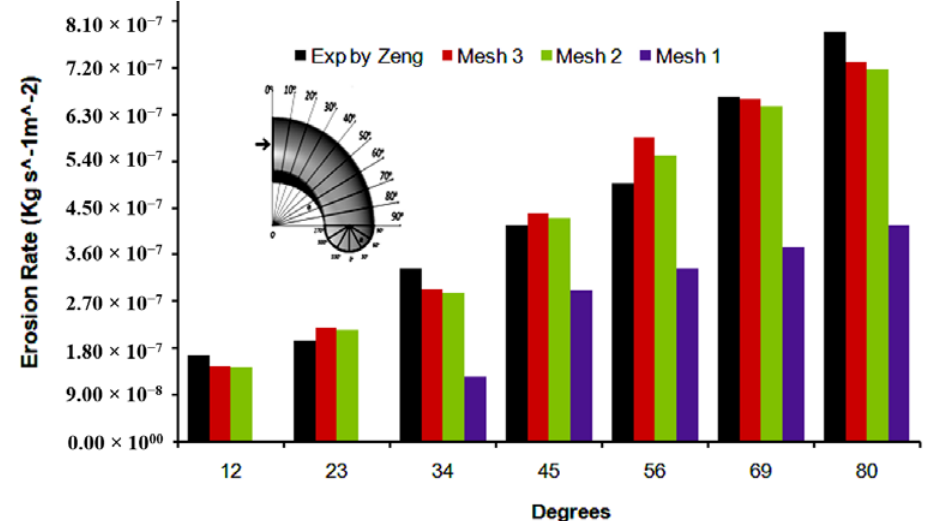
Figure 9. Comparison of numerical and experimental erosion rates along the elbow outer wall for the